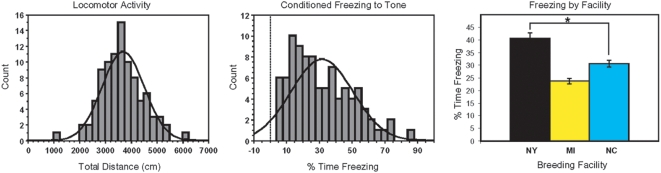
Behavioral phenotypes observed in Cohort 2.Frequency histograms for locomotor activity in an open field and the percent time spent freezing in response to a tone (freezing-to-tone) that was previously paired with a footshock are shown. The average freezing-to-tone scores (±SEM) for CD-1 mice grouped according facility of origin (Black–NY, Yellow–MI, Blue–NC) are also shown. *P = 0.001.